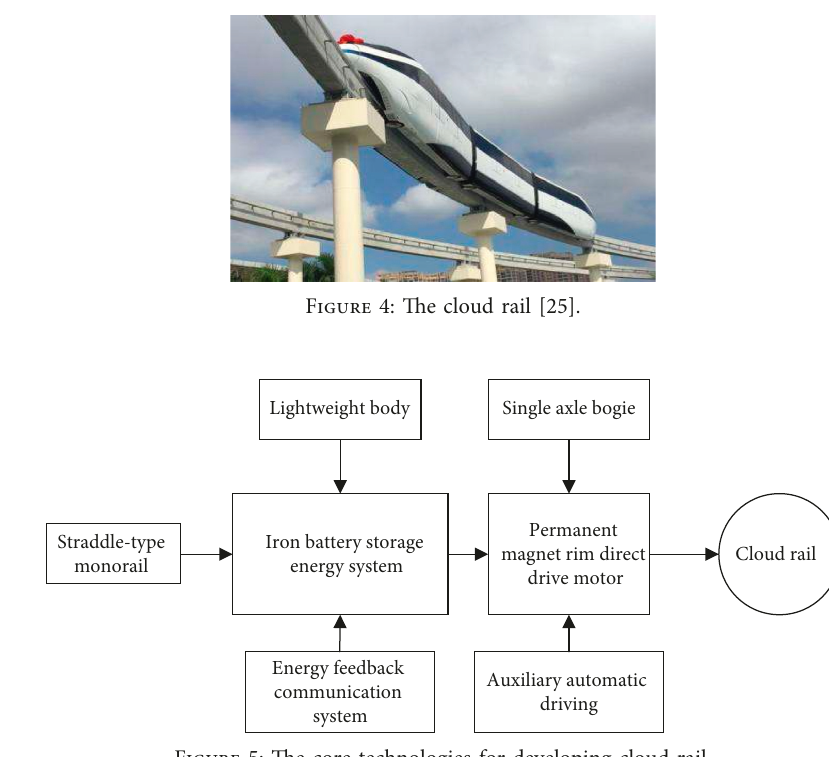
Figure 5: The core technologies for developing cloud rail. Table 4: The evaluation for social matching degree. Table 5: Economic feasible evaluation from Requirements Weights of importance